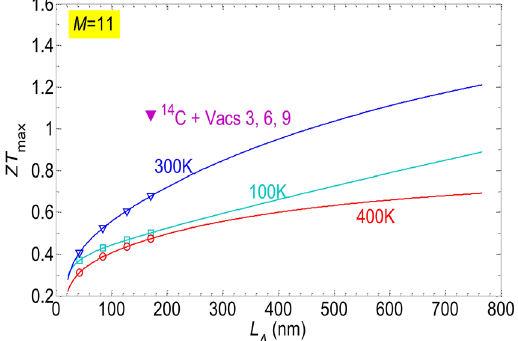
Figure 10. ZT max as a function of the device length for the case of a larger ribbon with M = 11. The open symbols and solid lines are numerical data and fitting curves for the case of 50% isotope doping and 5% vacancies in the m = 6 line. The filled symbol is the numerical results of the device with 50% isotope doping and 5% vacancies in lines m = 3, 6,